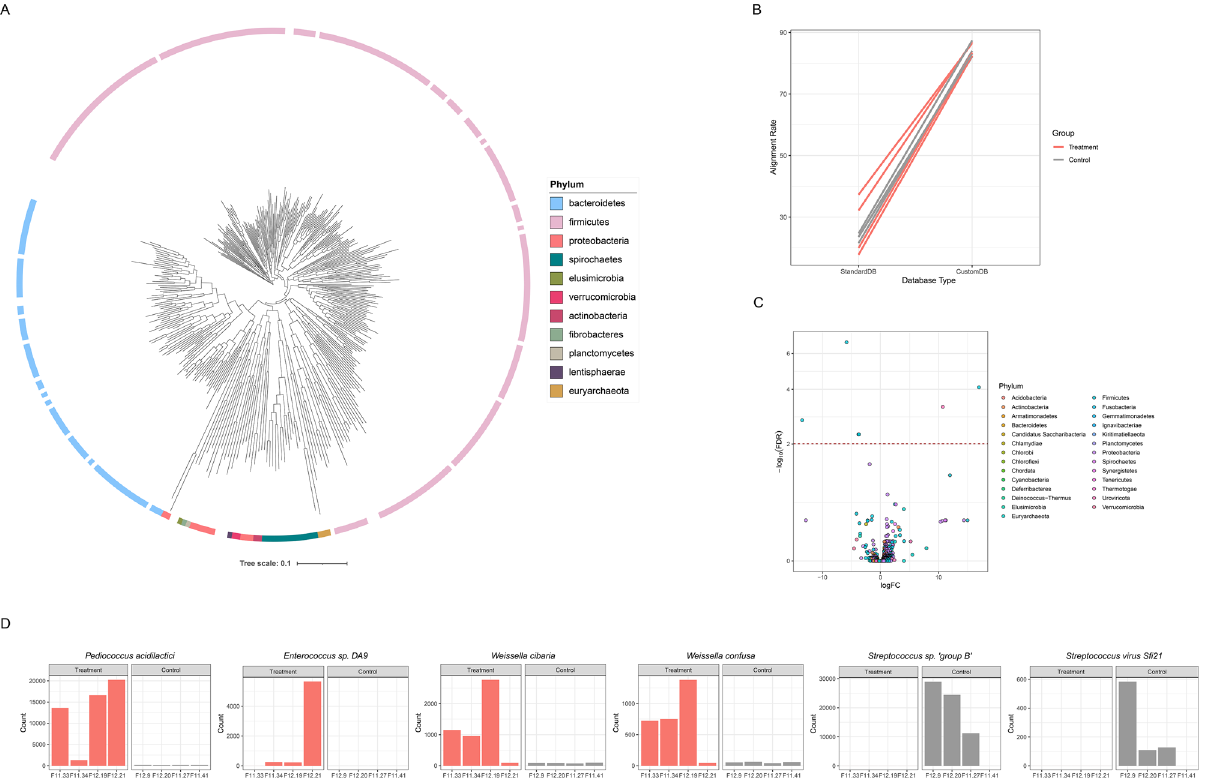
Figure 2. Analysis of the Metagenome-Assembled Genomes (MAGs) obtained using a host-customized database. ( A ) Phylogenetic tree of MAGs ( B ) rate of classified reads using standard database and custom database in kraken2. ( C ) Volcano plot for differentially abundant taxonomies. Each point represents the species-level taxonomies colored with phylum taxa. The taxa are presented with log 2 fold change (X-axis) and log 10 (FDR-corrected P-value) (Y-axis). Horizontal line represents P-value cut off (FDR P-value 0.01). ( D ) Differentially abundant taxonomies (FDR < 0.01) between groups. Red bars represent composition in samples from the treatment group while gray bars, composition in samples from the control